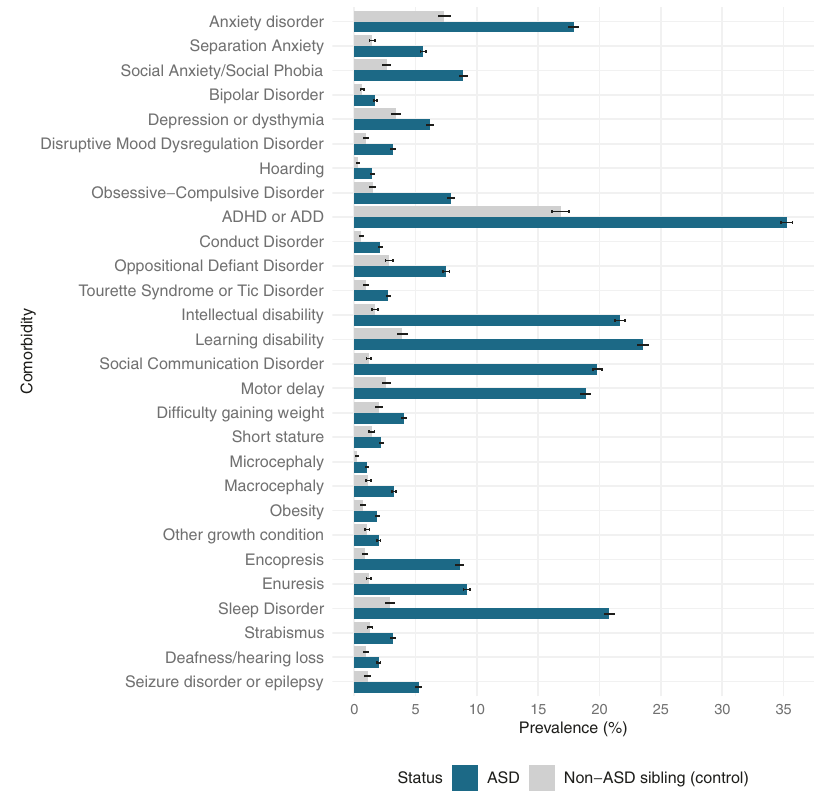
Fig. 2 Barplots illustrating the prevalence of comorbid conditions by ASD status. Prevalence estimates in unaffected siblings (grey bars) were standardized to year of evaluation, age and sex distribution in ASD cases (blue